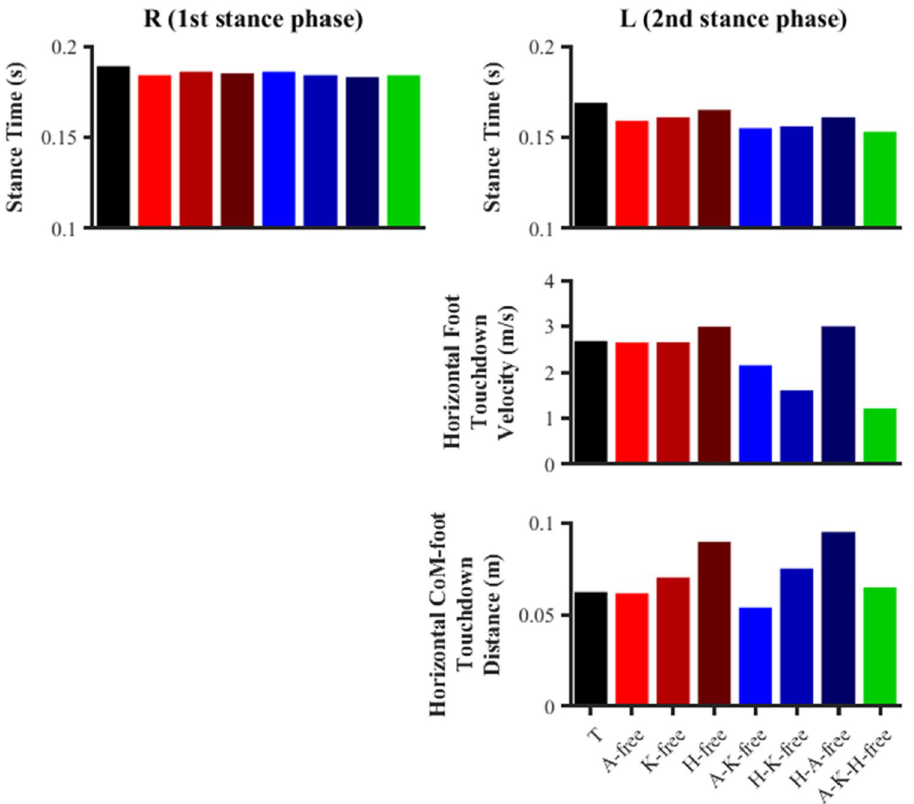
Figure 5. Right (R) and left (L) touchdown kinematics and stance phase durations for the data-tracking (T) and predictive simulations (A-free, K-free, H-free, A-K-free, H-K-free, H-A-free, A-K-H-free). A positive horizontal CoM-foot touchdown distance indicates that the foot was ahead of the